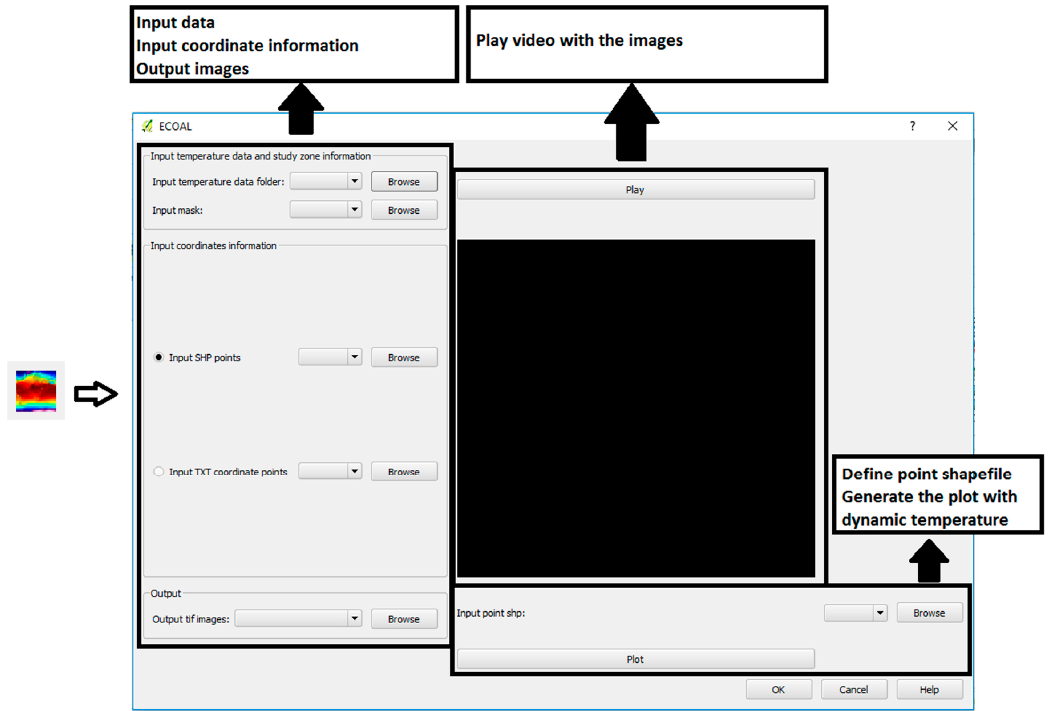
Figure 5. ECOAL button ( left ) and graphic interface ( right ).